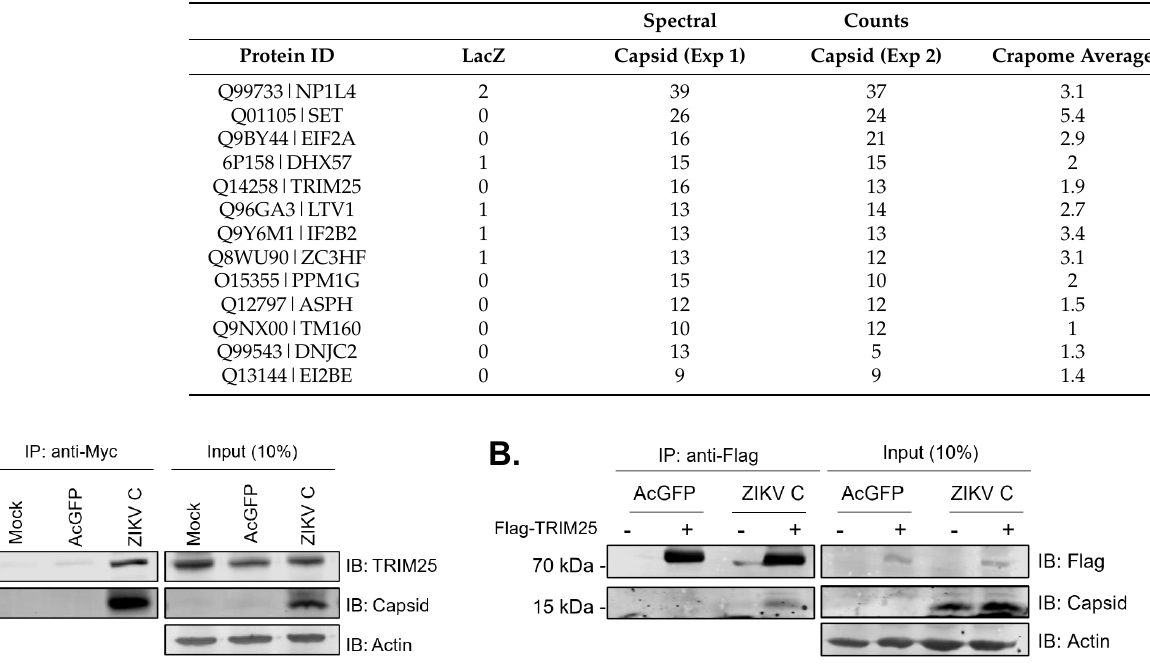
Table 3. Affinity Purification Mass Spectrometry performed with ZIKV capsid protein reveals an interaction with the host protein TRIM25. The top twelve other high confidence hits based on spectral counts from two independent experiments are also shown.